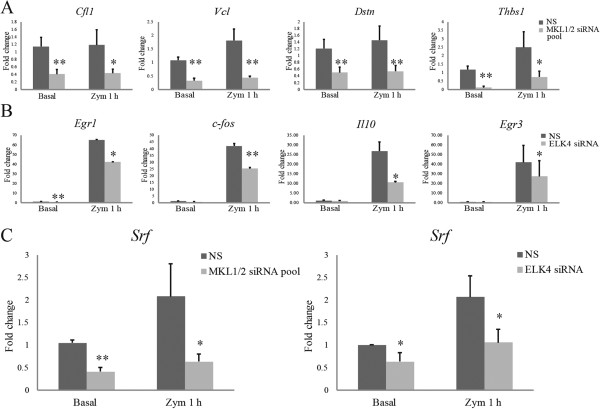
Expression profiles of MKL1/2 and ELK4 dependent target genes in response to zymosan treatment. (A) and (B) Expressions of MKL1/2 dependent genes (Cfl1, Dstn, Vcl and Thbs1) and ELK4 dependent genes (Il10, c-fos, Egr1 and Egr3) were analyzed by Q-PCR. Thioglycollate-elicited macrophages were transfected with NS or specific siRNAs for MKL1/2 or ELK4, as indicated, and treated with or without zymosan for 1 h. (C)Srf mRNA expression in response to MKL1/2 or ELK4 knockdown under basal conditions or after treatment with zymosan for 1 h. Target gene expression is represented as the average fold change compared to NS siRNA transfected samples of three independent experiments. **p < 0.01 vs. NS; *p < 0.05 vs. NS. Error bars represent standard deviations.